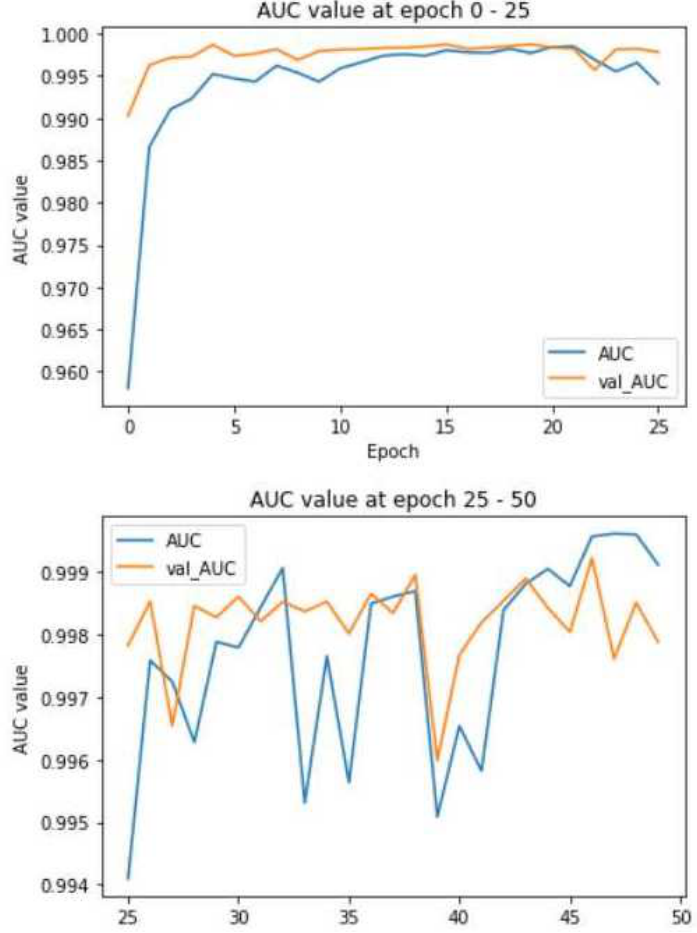
Figure 8. Evaluation of the training and testing accuracy in